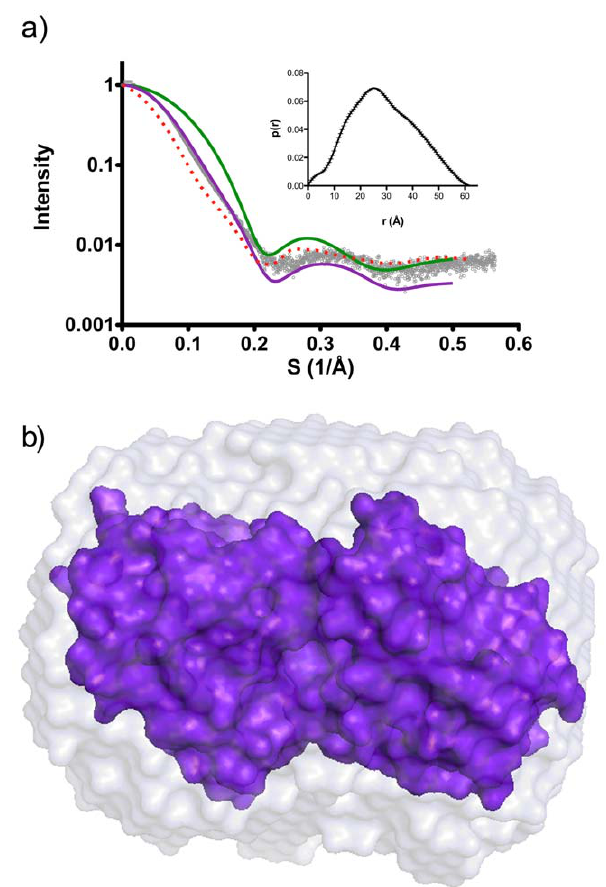
Figure 6. SAXS results. (A) The experimental scattering curve of yp TpxC61S (grey), overlaid with the curves for monomeric Tpx (green) and dimeric Tpx (purple) (calculated using CRYSOL [50]) confirming the dimeric solution state of the protein. The fit of the ab initio model to the experimental data is shown in red. Inset is the distance distribution function (p(r) versus r) of yp TpxC61S with error bars. (B) Space-filled crystal structure of yp TpxC61S (purple) superposed onto the averaged DAMMIN ab initio model (grey) using the program SUPCOMB [49].